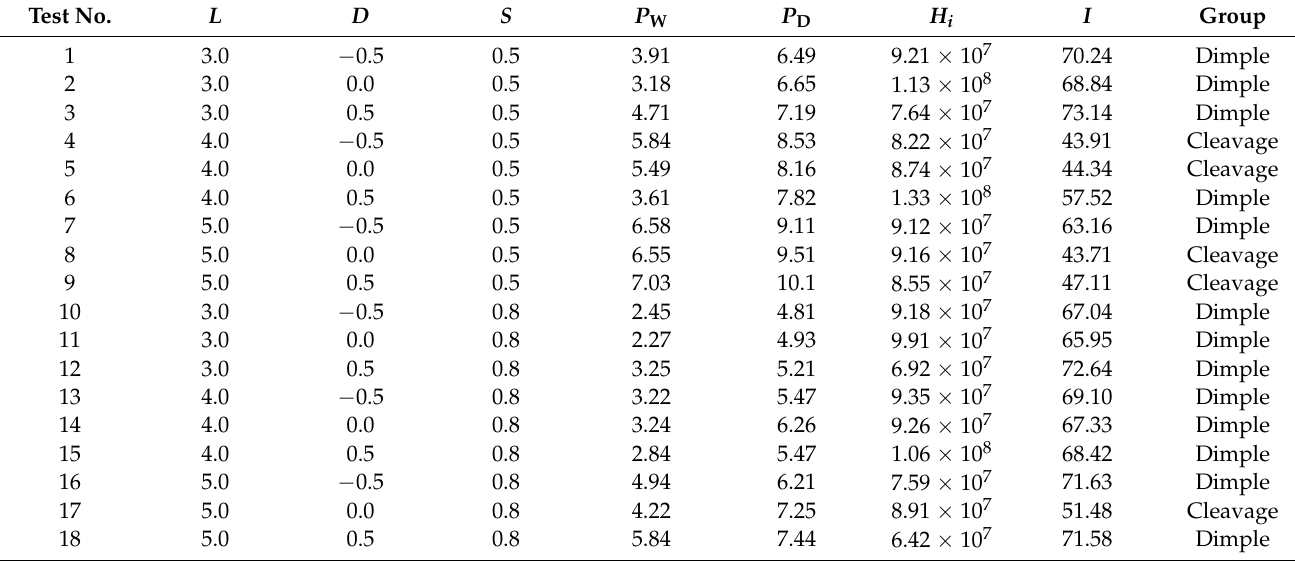
Table 10. Learning data for discrimination of welding quality.